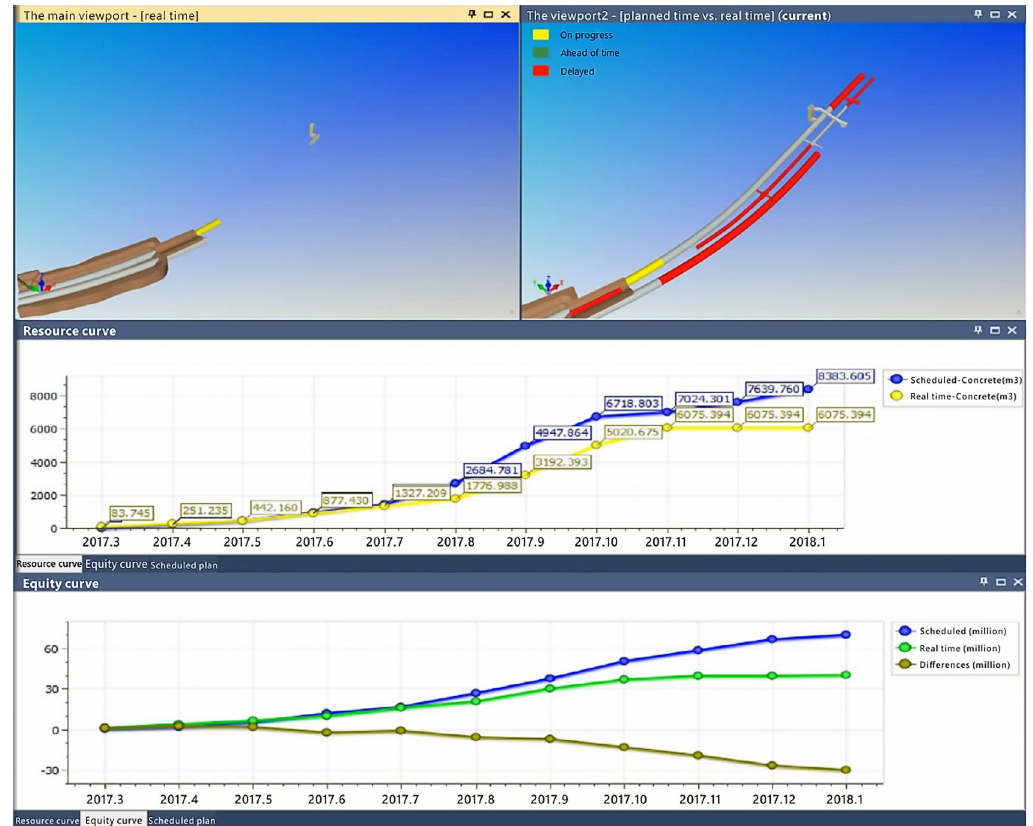
Figure 11. BIM5D software can simulate the construction cost control by comparing the planned and real-time schedules